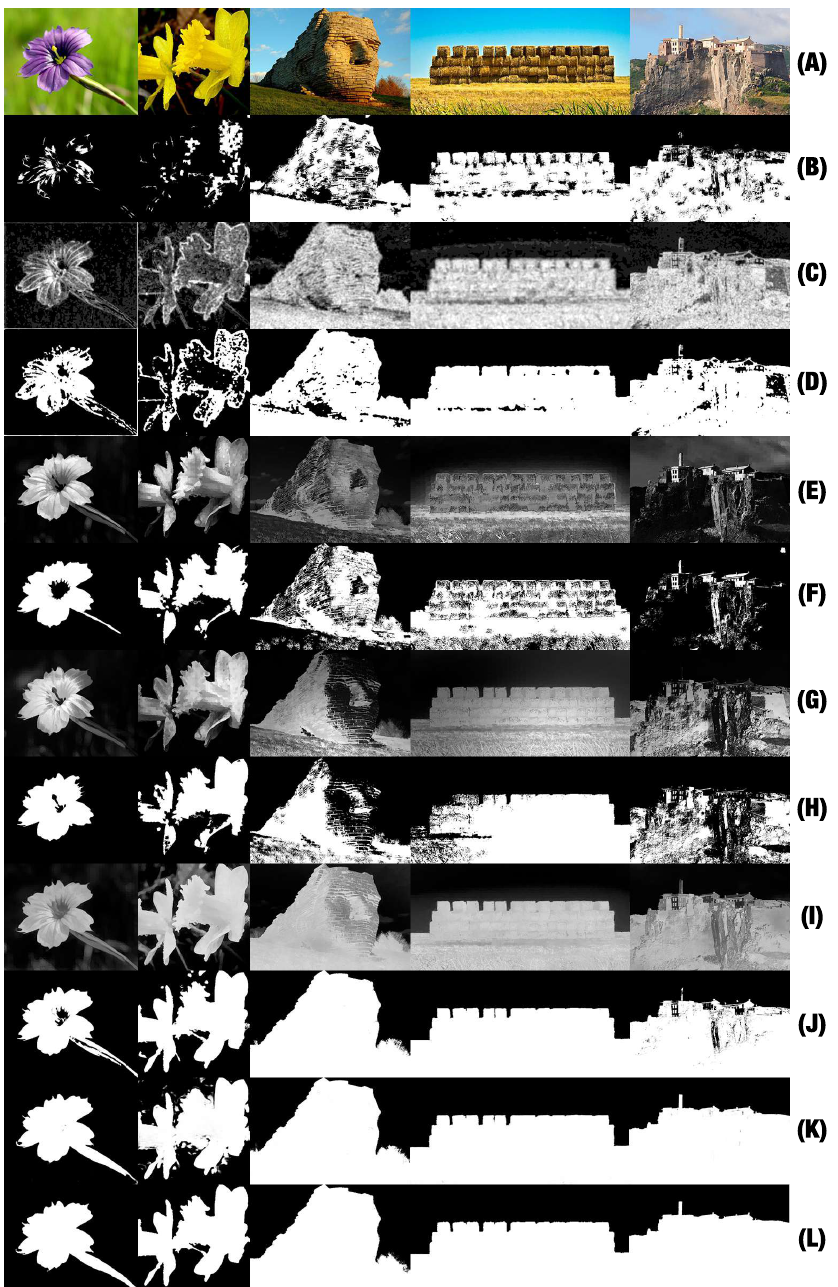
Figure 11. Examples of ROI maps. ( a ) Original images. ( b ) Tang’s [25] sharpness maps. ( c , d ) Aydin’s [5] clearness maps and the binarized versions of them. ( e , f ) Perazzi’s [27] color saliency maps and the binarized versions of them. ( g , h ) Zheng’s [28] color saliency maps and the binarized versions of them. ( i , j ) Handcrafted ROI maps based on both sharpness and color information and the binarized versions of them. ( k ) ROI maps generated by the first deep model. ( l ) ground